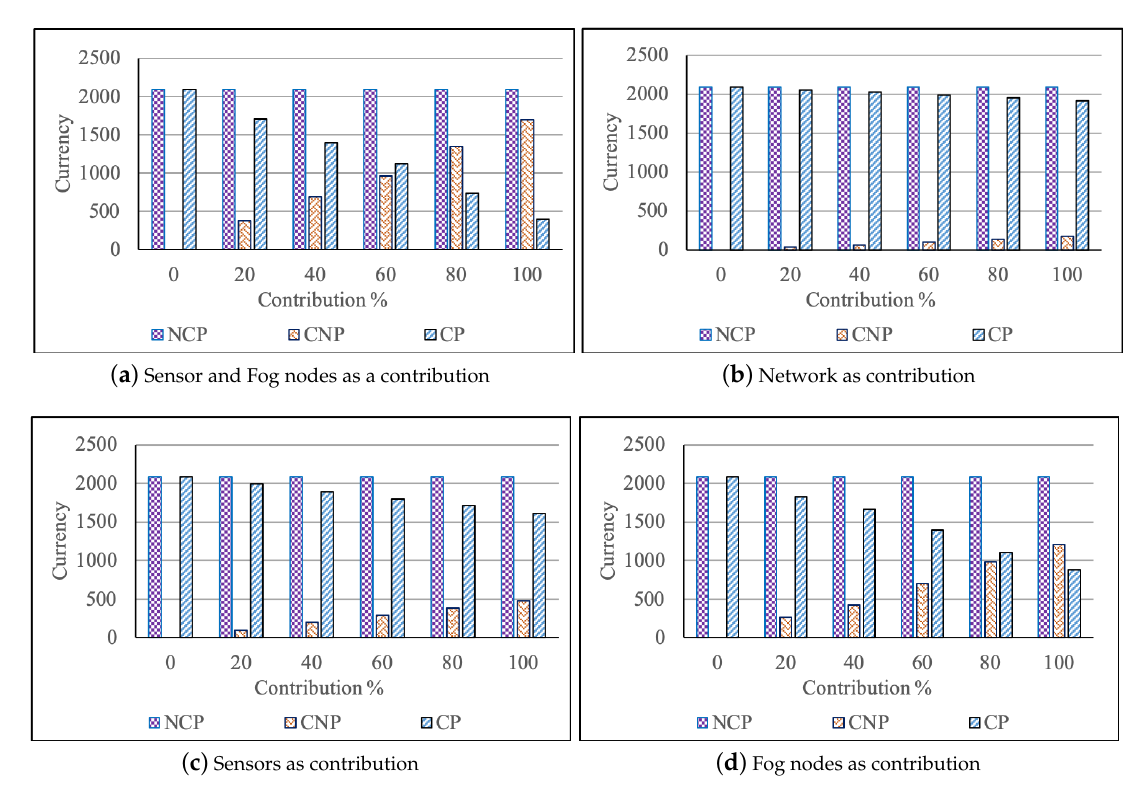
Figure 2. Cost for different cases of infrastructure as a